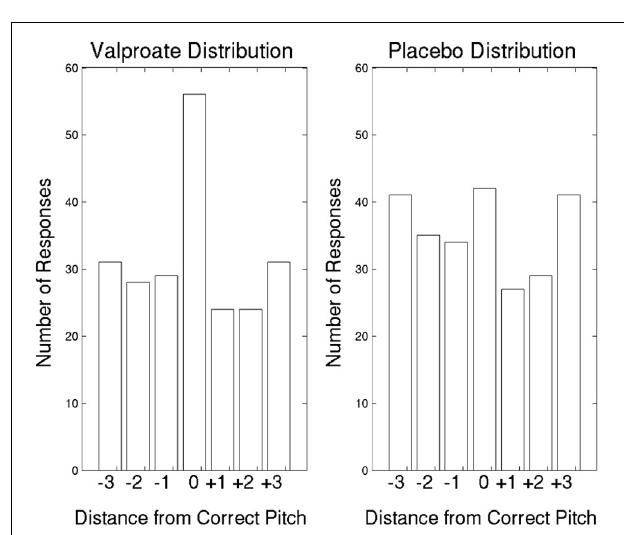
FIGURE 3 | The AP data in the first treatment arm, with errors shown as deviations from the correct pitch category measured in whole tones. Pitch categories repeat every octave. Thus, + 3 whole tones is the same as − 3 whole tones, and the corresponding bars in the figure represent the same responses. The expected correct response is a distribution with a mode at 0, with a deviation of